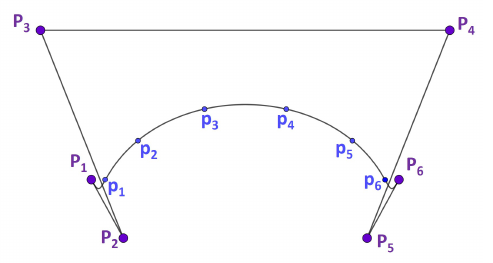
Figure 1. Curve fitting by interpolation, where p 1 , p 2 , p 3 , p 4 , p 5 , p 6 are the given data and P 1 , P 2 , P 3 , P 4 , P 5 , P 6 are the control points.